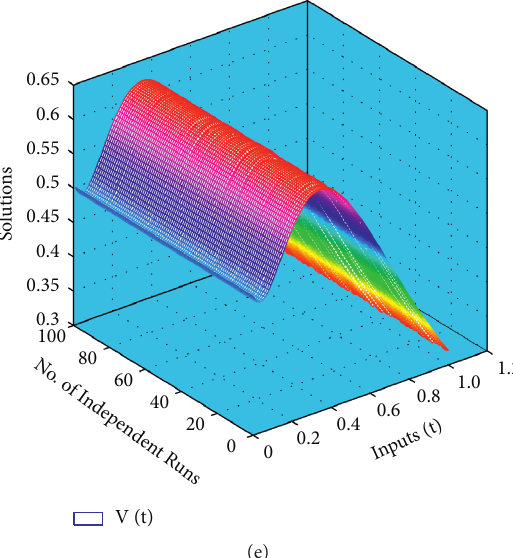
Figure 3: Problem 1: graphical evaluation tumor growth ratio ( r ) to rate of cell lysis ( δ ) f � 0, the inverse of burst size parameter g � 0 . 02, and the viral decay ( α ) ratio to rate of cell lysis ( δ ) h � 0 . 15. (a) Solution for f � 0, g � 0.02, and h � 0.15 with initial conditions I (0) � 0.6, U (0) � 0, and V (0) � 0.5, (b) weights obtained by ANN-SCA-SQP for CVRT, (c) solutions of 100 independent runs of uninfected cells, I ( t ), (d) solutions of 100 independent runs of infected cells, U ( t ), and (e) solutions of 100 independent runs of free viruses, V ( t